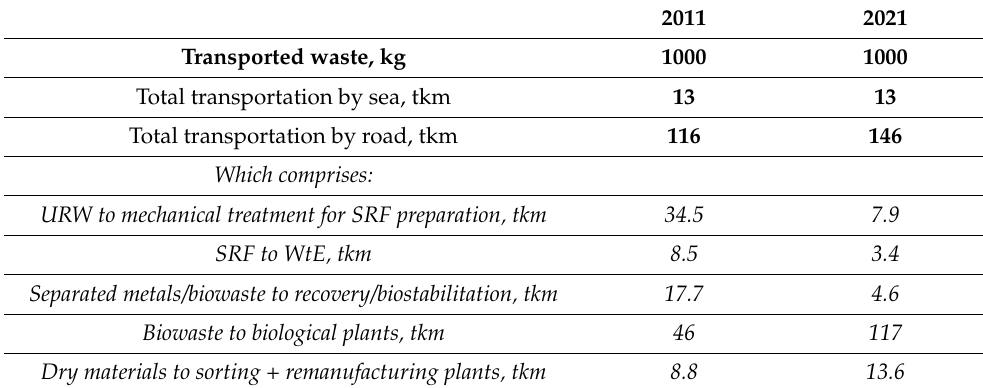
Table 5. Environmental burdens related to transportation stages for all waste streams. Source: W-MySir